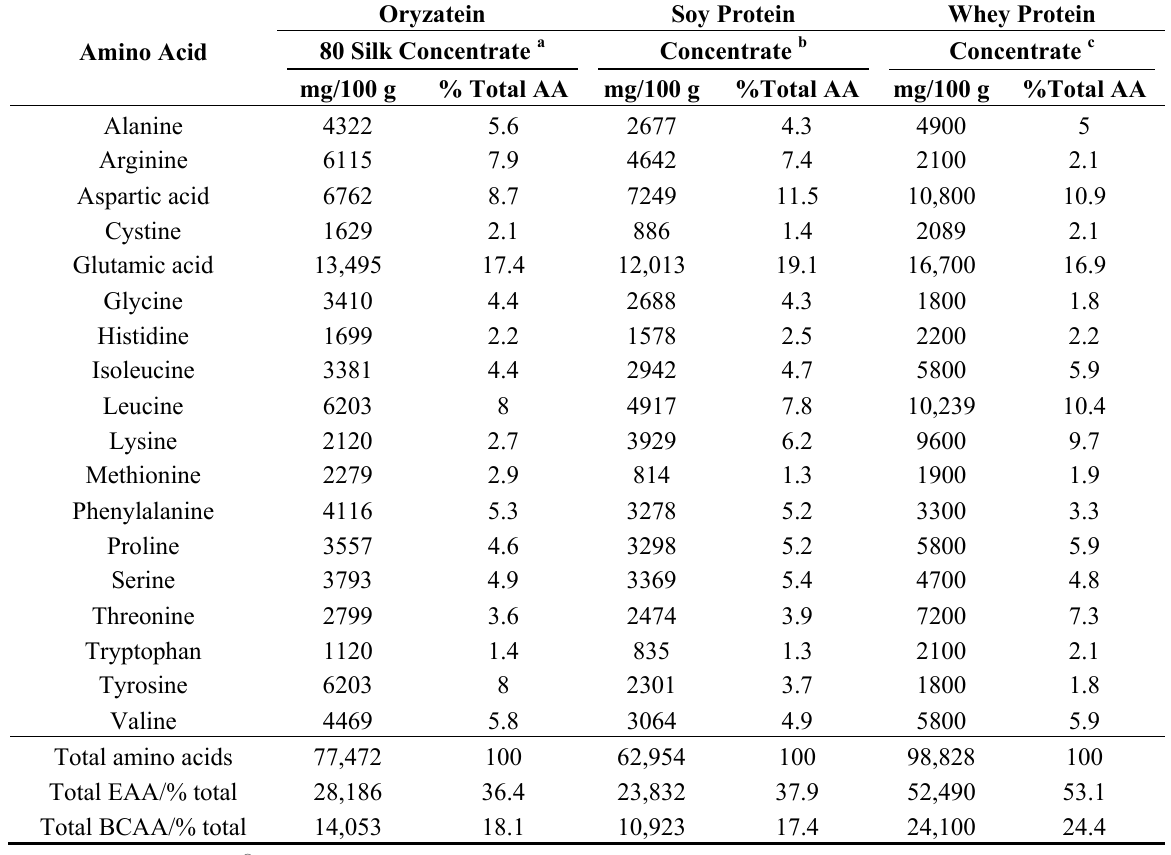
Table 3. Amino Acid Composition of Oryzatein Brown Rice Protein Concentrate, Whey Protein Concentrate and Soy Protein